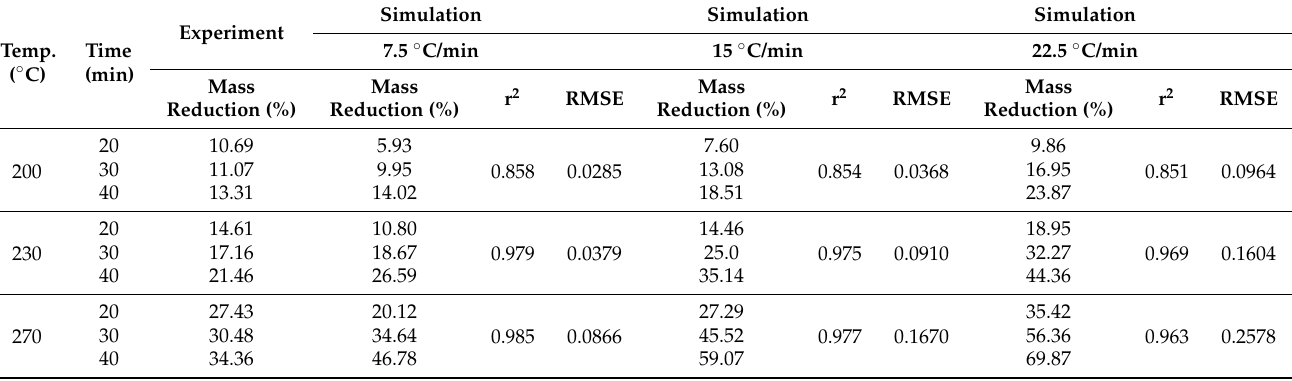
Table 8. Perilla mass reduction